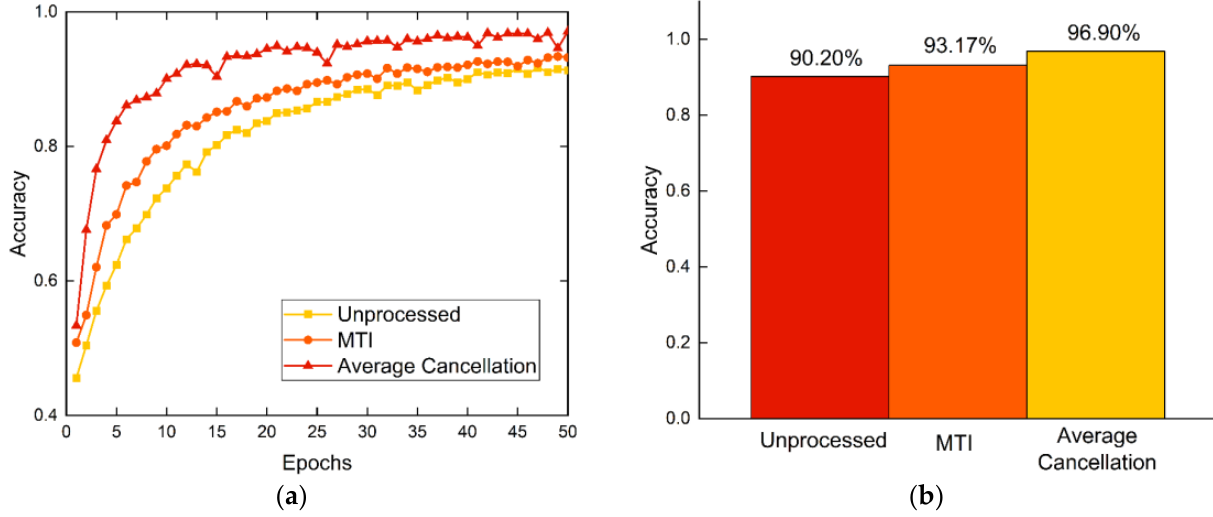
Figure 16. Recognition performance of three clutter suppression algorithms: ( a ) curves of validating accuracy varying with the number of epochs and ( b ) test accuracy.